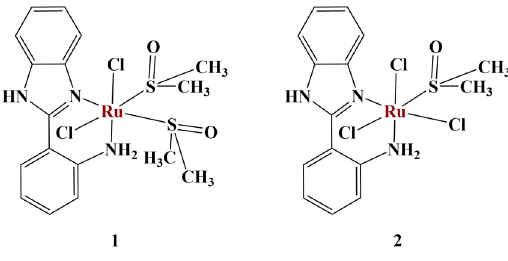
Figure 14. Complexes 1 and 2 presented in [60].